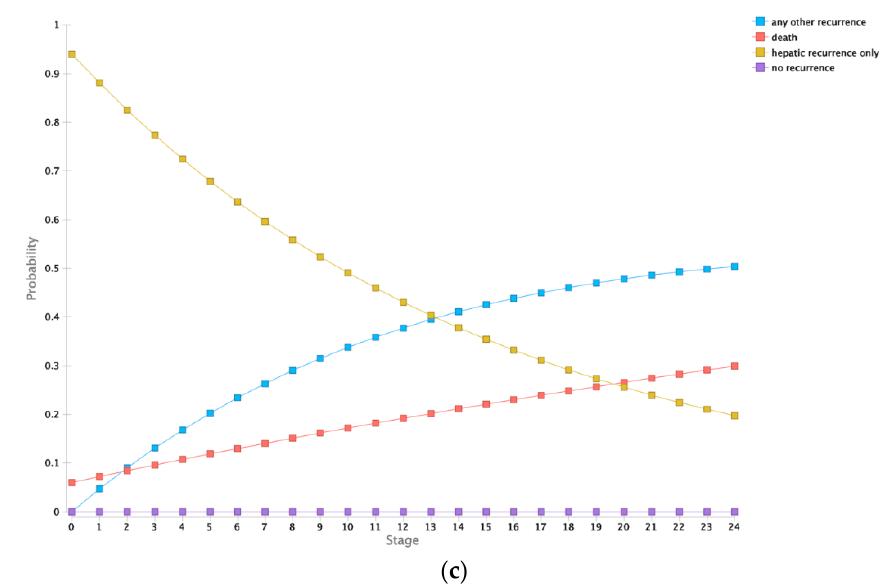
Figure 1. Markov simulation for two years. ( a ). Outcomes for patients receiving a timely reablation (true positive). ( b ). Outcomes of patients without initially needed reablation (true negative and false positive). ( c ). Outcomes of patients with delayed reablation (false negative).